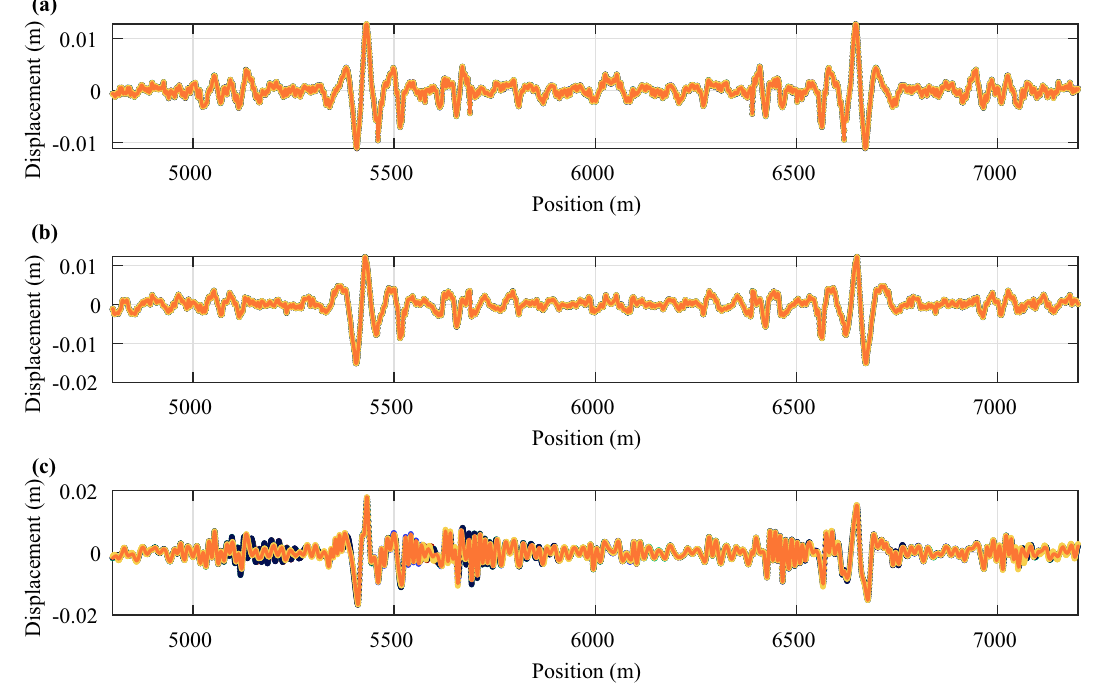
Fig. 18 Results from five simulations where noise was added (the non-orange lines) compared with the original simulation (no noise added). The noise used the standard deviations from LOO: a post-kernel displacement of the left rail at the position of the front wheelset for the original simulation (orange line) and five of the simulations with noise added to the system; b post-kernel displacement of the right rail at the position of the front wheelset for the original simulation (orange line) and five of the simulations with noise added to the system; c displacement of the front wheelset for the original simulation (orange line) and five of the simulations with noise added to the system. Some deviations from the original simulation can be seen, e.g., around 5250